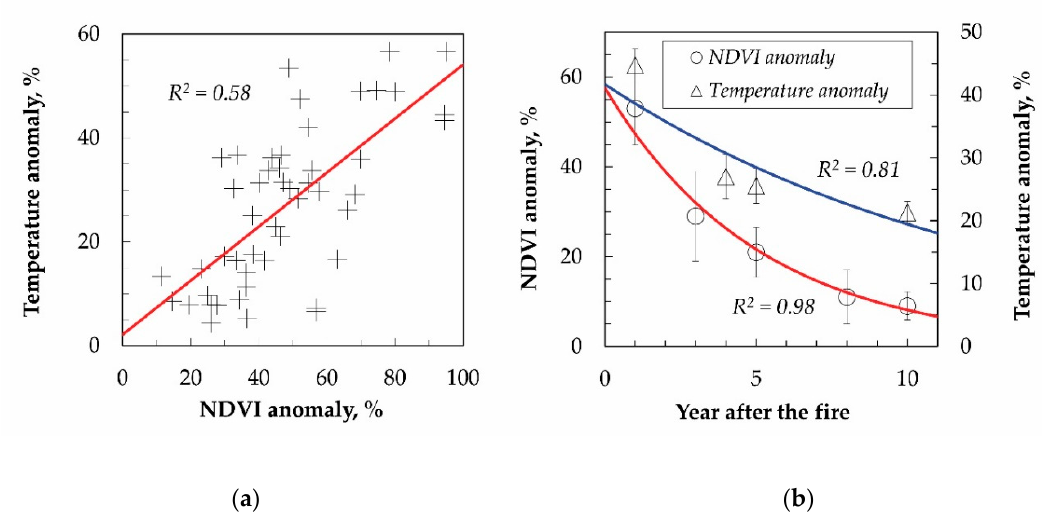
Figure 3. NDVI and temperature from 50 selected fire-damaged plots relative to non-disturbed areas averaged for June–August: ( a ) dependence between anomalies of temperature and NDVI; ( b ) dynamics of NDVI anomaly (1) and surface temperature anomalies (2) for 10 years after a fire.